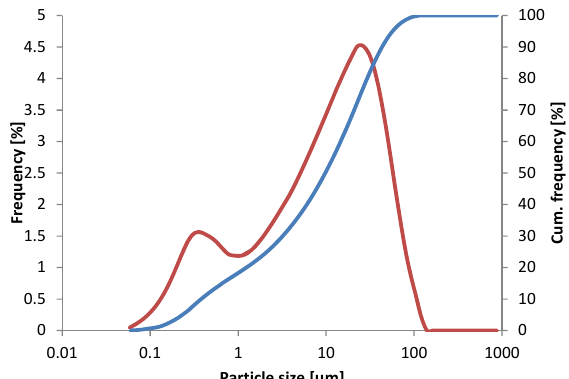
Figure 1. Particle size distribution of the cement used (laser